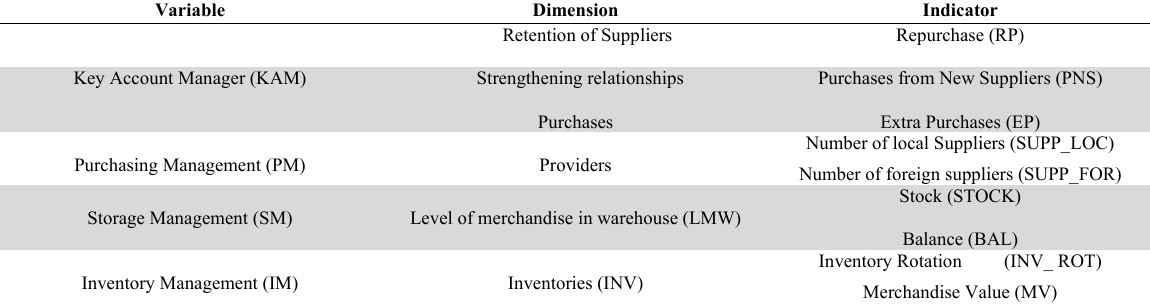
Variables, dimensions and